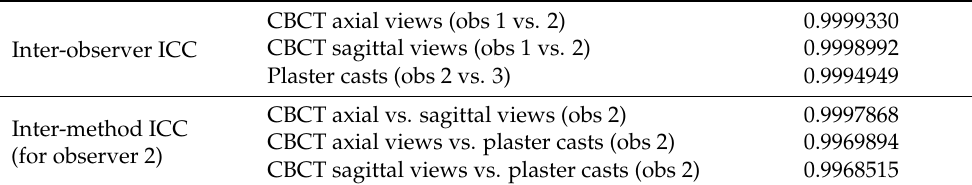
Table 1. Intra-class correlation coefficients (ICC) show the correlation between observers and methods. CBCT axial views (obs 1 vs. Inter-observer ICC